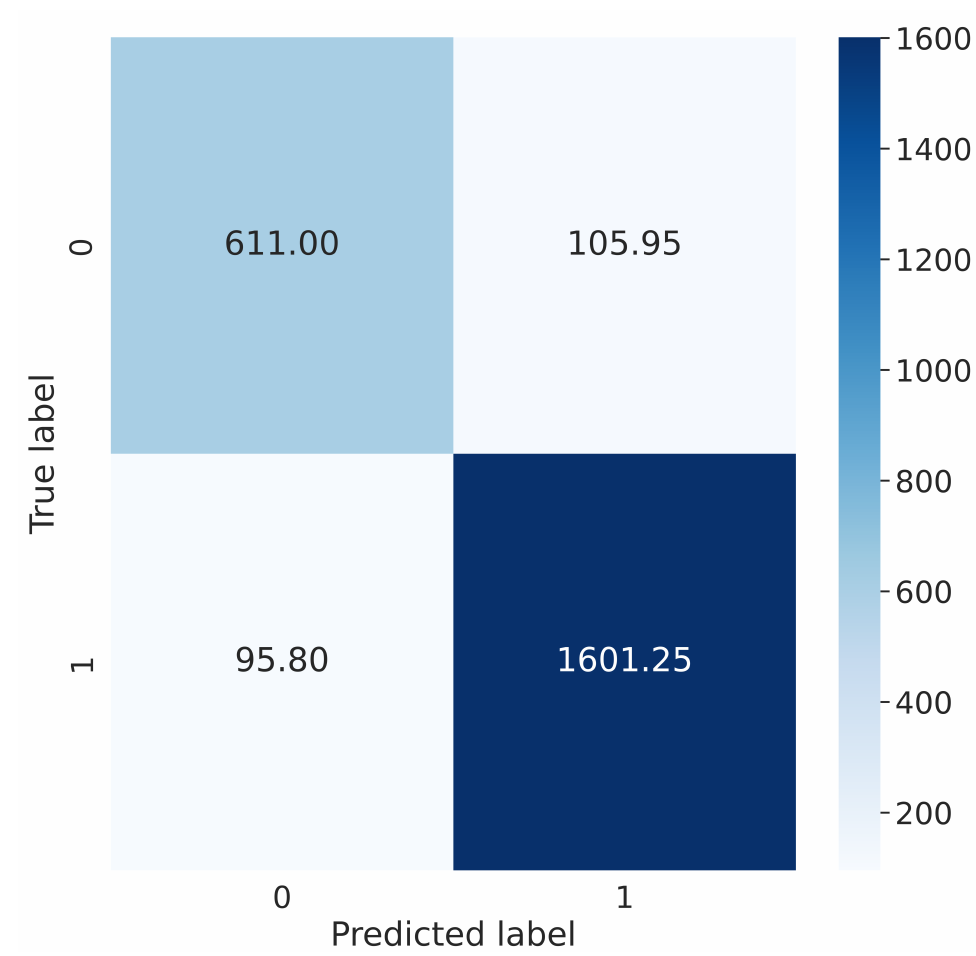
Figure 3. Confusion matrix of test set